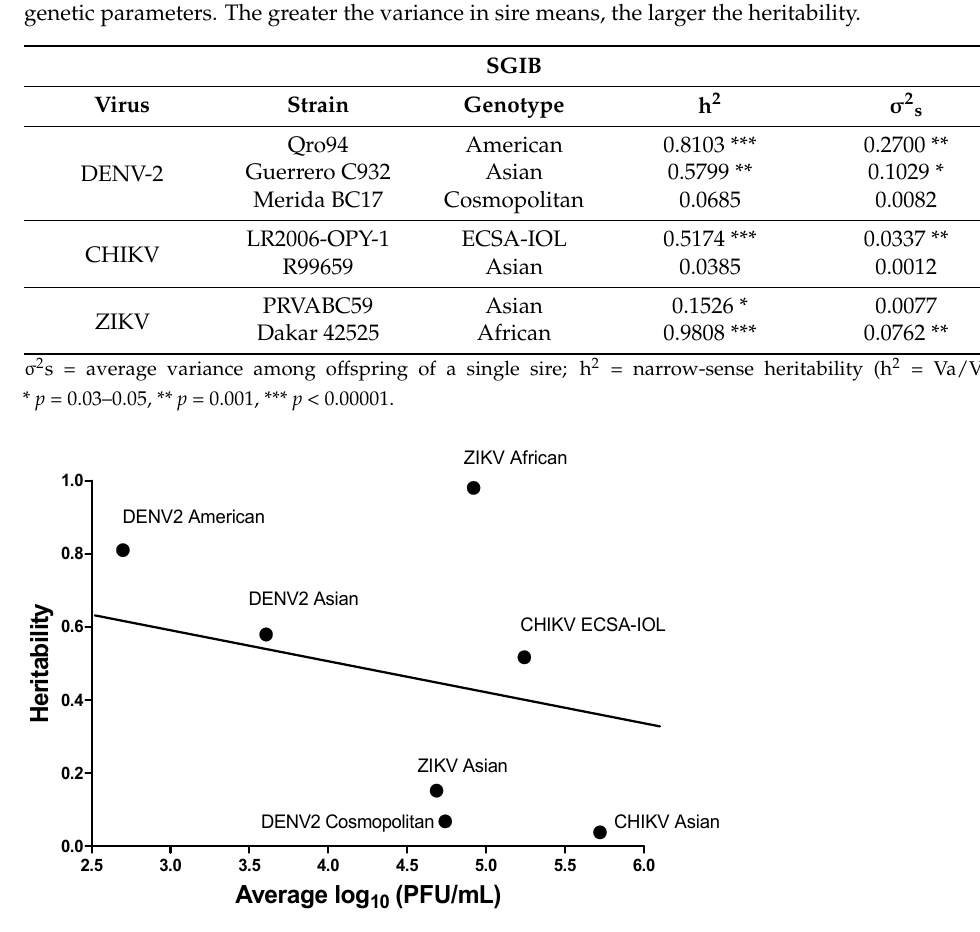
Figure 7. Correlation analysis to test whether the average log 10 (PFU/mL) virus in the salivary glands are negatively correlated with the magnitude of heritability.